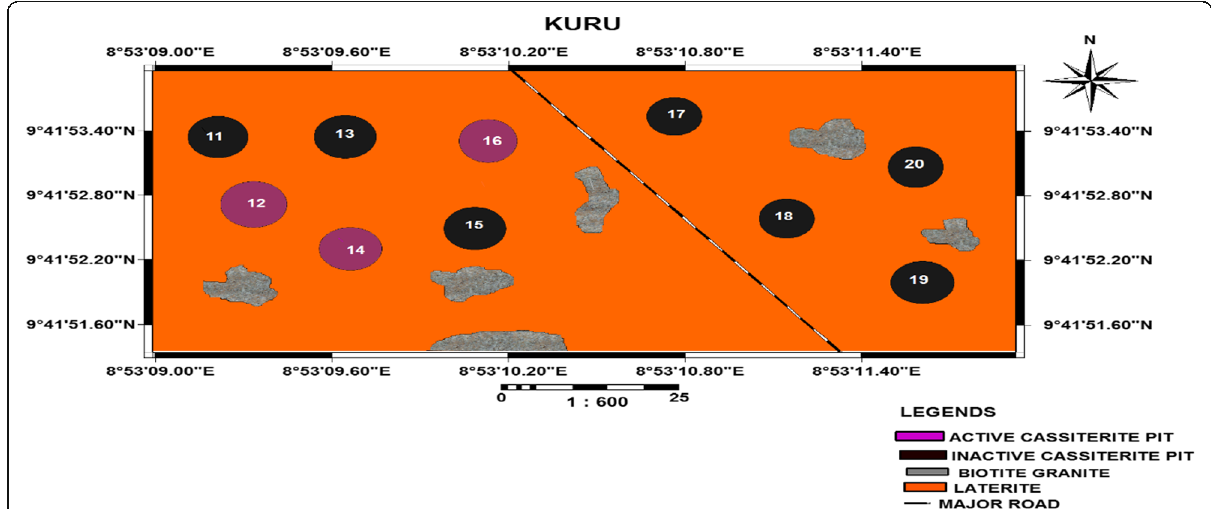
Fig. 3 An image of Kuru-Jentar in Plateau State showing both the active and inactive